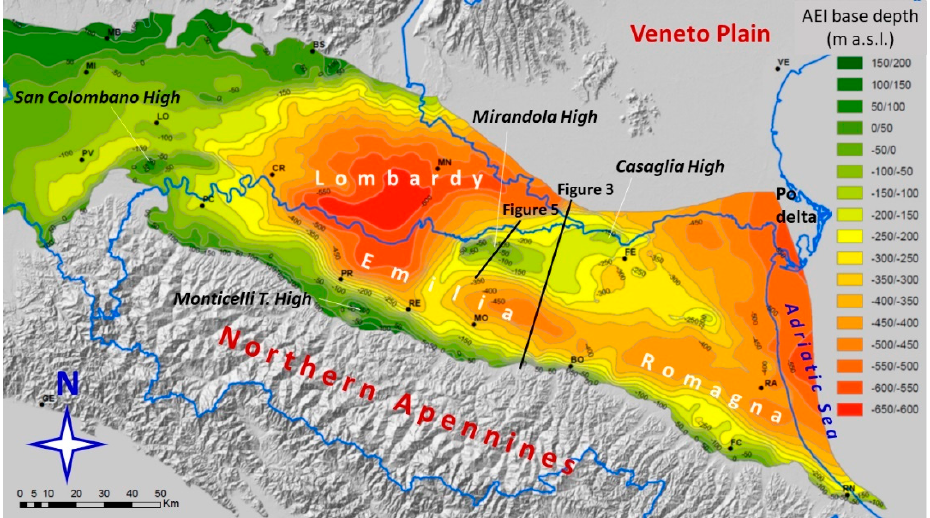
Figure 4. Map of the basal unconformity of the alluvial deposits in the Lombard and Emilia-Roma- gna plain (isobaths referred to the sea level) (modified from [11,12]); the black dots indicate the main cities.